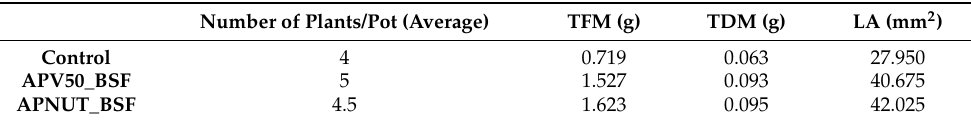
Table 3. Germination and growth values obtained growing lettuce in control condition (substrate without fertilizer) and with fertilizer APV and APNUT.